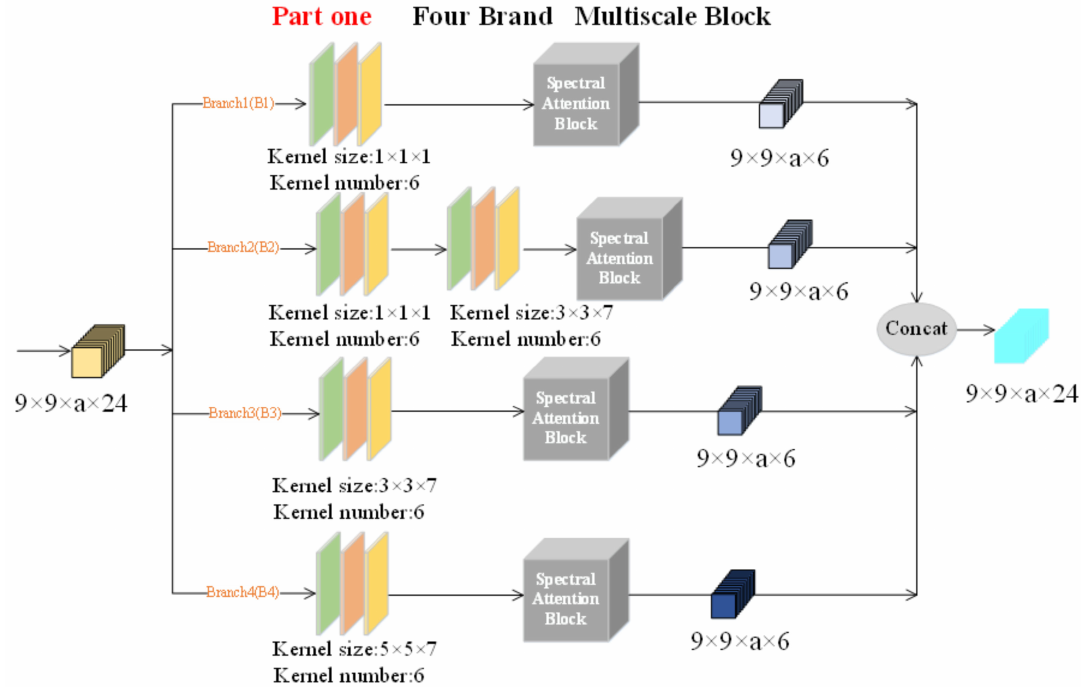
Figure 12. Schematic diagram of FBMB.